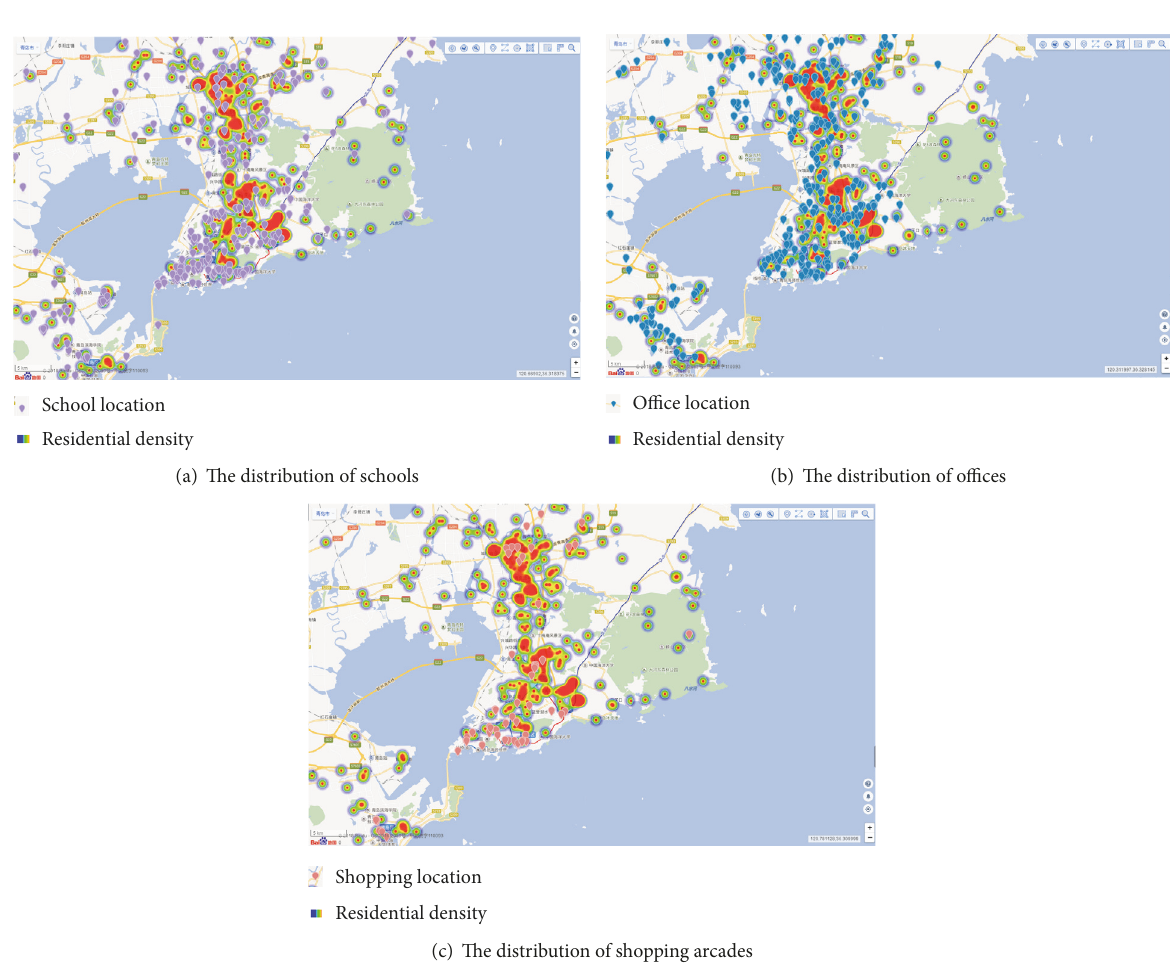
Figure 7: Distributions of residential communities, schools, offices, and shopping centers in